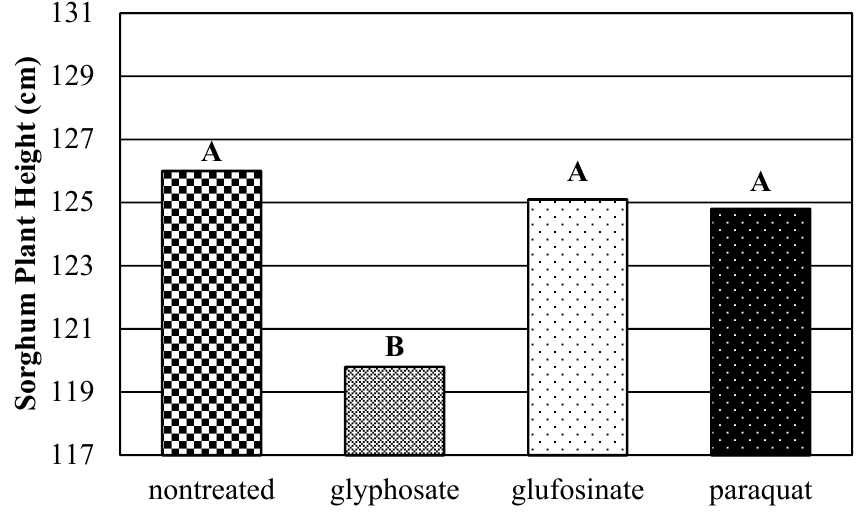
Figure 5. Grain sorghum heights for each herbicide treatment, averaged over application timing, at 14 DAA in 2017. Same letters on bars indicate no significant differences at p < 0.05, according to Fisher’s least significant difference test.